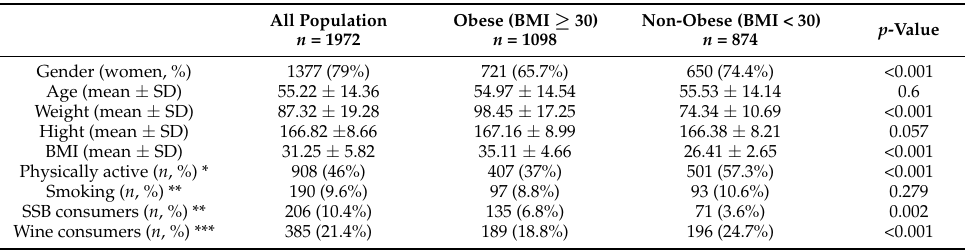
Table 1. Descriptive characteristics of study population by obesity